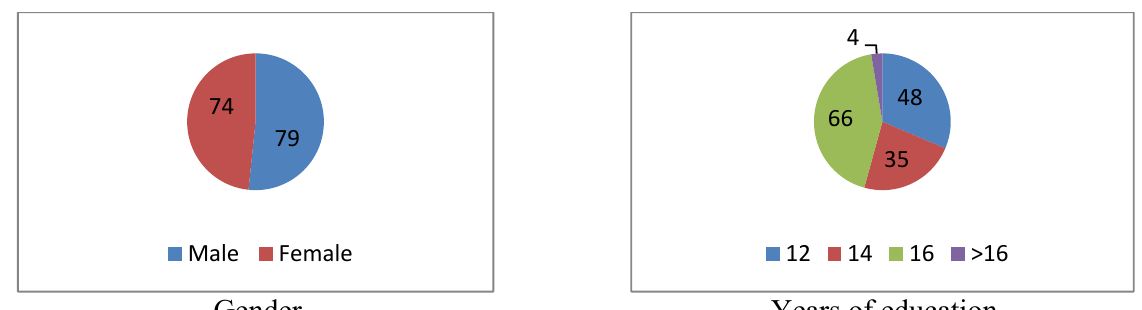
Fig. 1. Personal characteristics of the